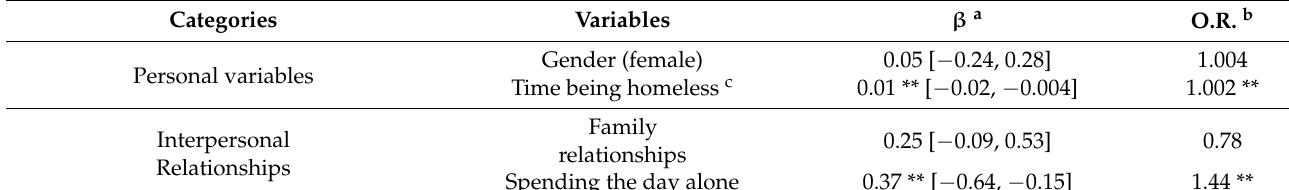
Table A3. Impact of some variables on the self-perceived health status (ordinal